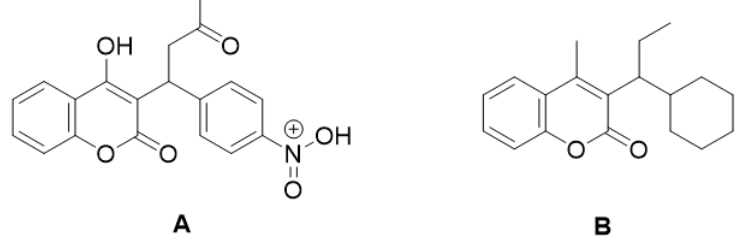
Figure 10. Chemical structures of anticoagulants. acenocoumarol ( A ), phenprocoumon ( B ).